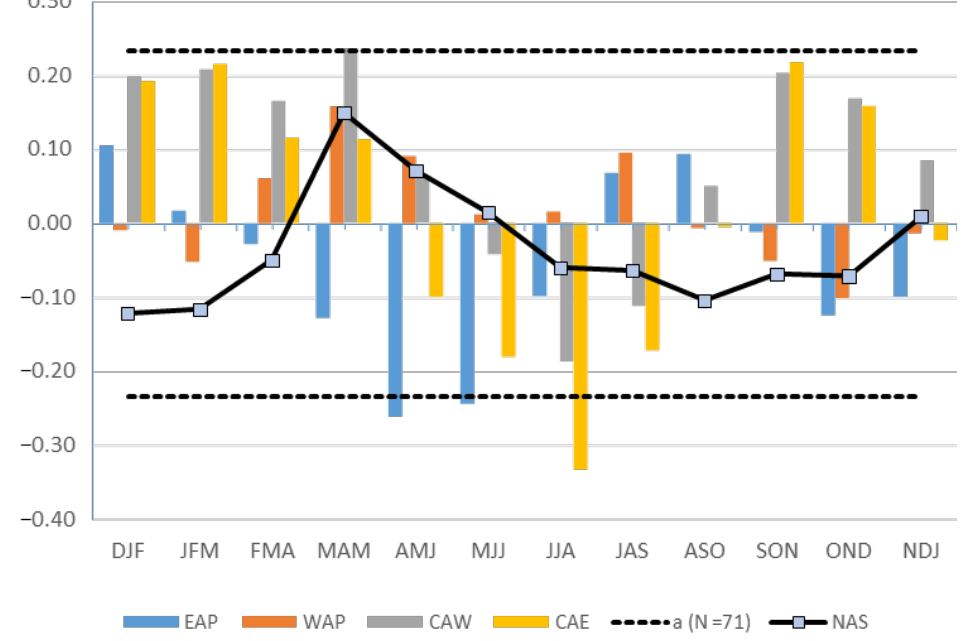
Figure 8. This is the same as Figure 7, but it demonstrates the mean ERA5 daily maximum wind speed with critical rho = 0.2484 for N =